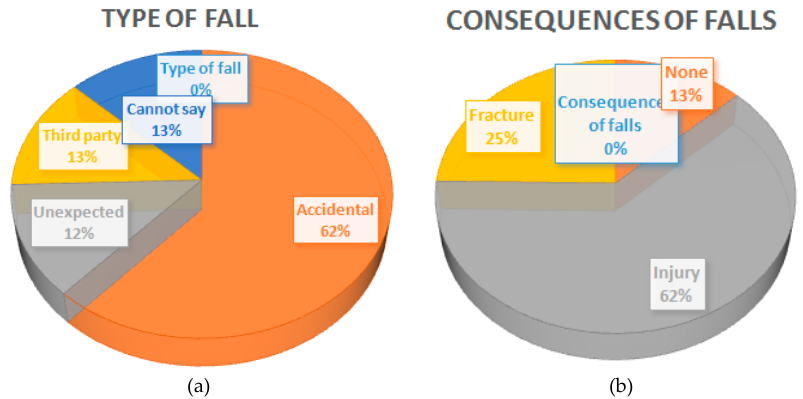
Figure 1. Type and consequences of falls. ( a ) Type of fall; ( b ) Consequences of